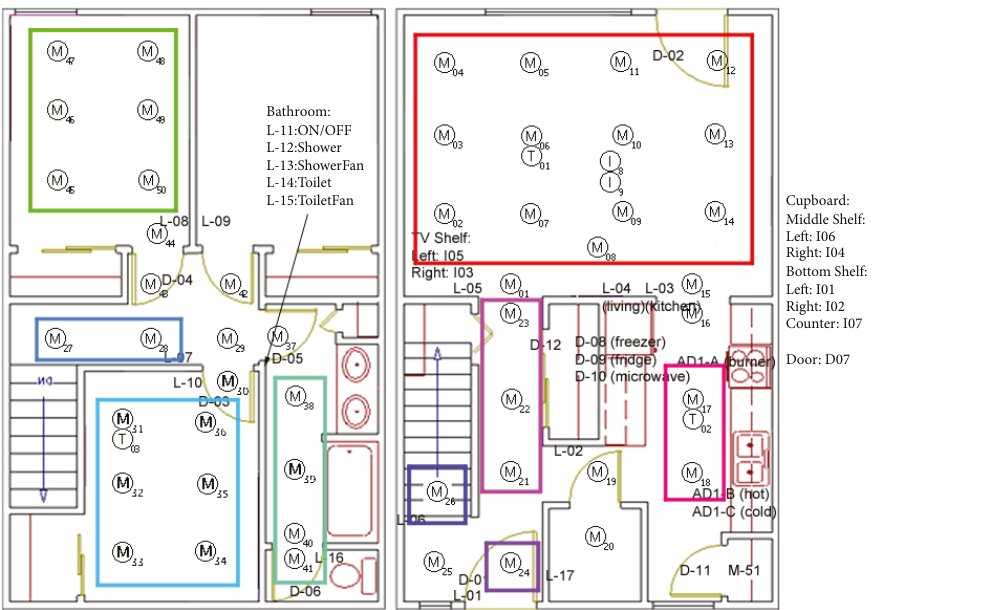
Figure 5: An example of sensor clusters where different color indicates different regions or rooms in the monitoring area.